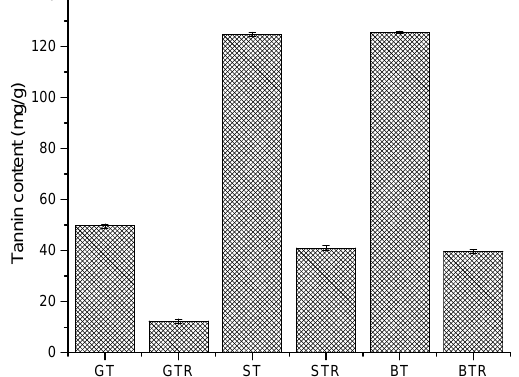
Figure 3. Comparative Yields of Extracted Tannins and Resins Expressed as Mean ± SD. Key: silver wattle tannin (ST), silver wattle tannin resin (STR), black wattle tannin (BT), black wattle tannin resin (BTR), green wattle tannin (GT) and green wattle tannin resin (GTR). There is a significant difference ( p ≤ 0.05) in the amount of cross ‐ linkable tannin and extractable tannin; this indicates a difference in the tannin chemistry resulting in the observed variation. Depending on the Acacia species, about 25–40% of the total tannin can be modified into a resin while the uncross ‐ linkable tannin can still find application in the tanning industry [36,37].